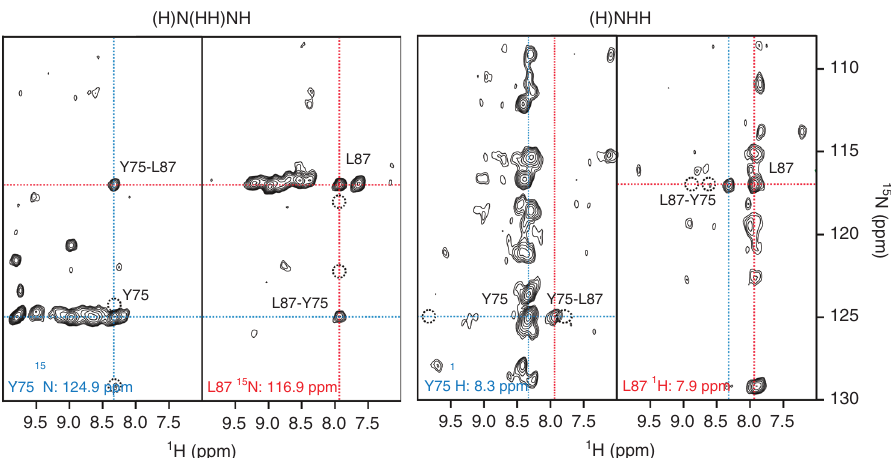
Fig. 2 Set of two planes from the 3D (H)NHH and (H)N(HH)NH spectra. Strips taken at the 15 N chemical shifts of Y75 (left) and L87 (right) from the (H)N (HH)NH and (H)NHH spectra, respectively. The proton – proton cross-peak pattern is indicative of cross-strand hydrogen bonding between the backbone amide and carbonyl groups of tyrosine 75 and leucine 87. Red lines correspond to the 1 H and 15 N chemical shifts of L87. Blue lines correspond to the 1 H and 15 N chemical shifts of Y75. A total of four cross peaks are present at the intersections of red and blue lines. Dotted circles indicate positions of potential sequential cross peaks (see text)